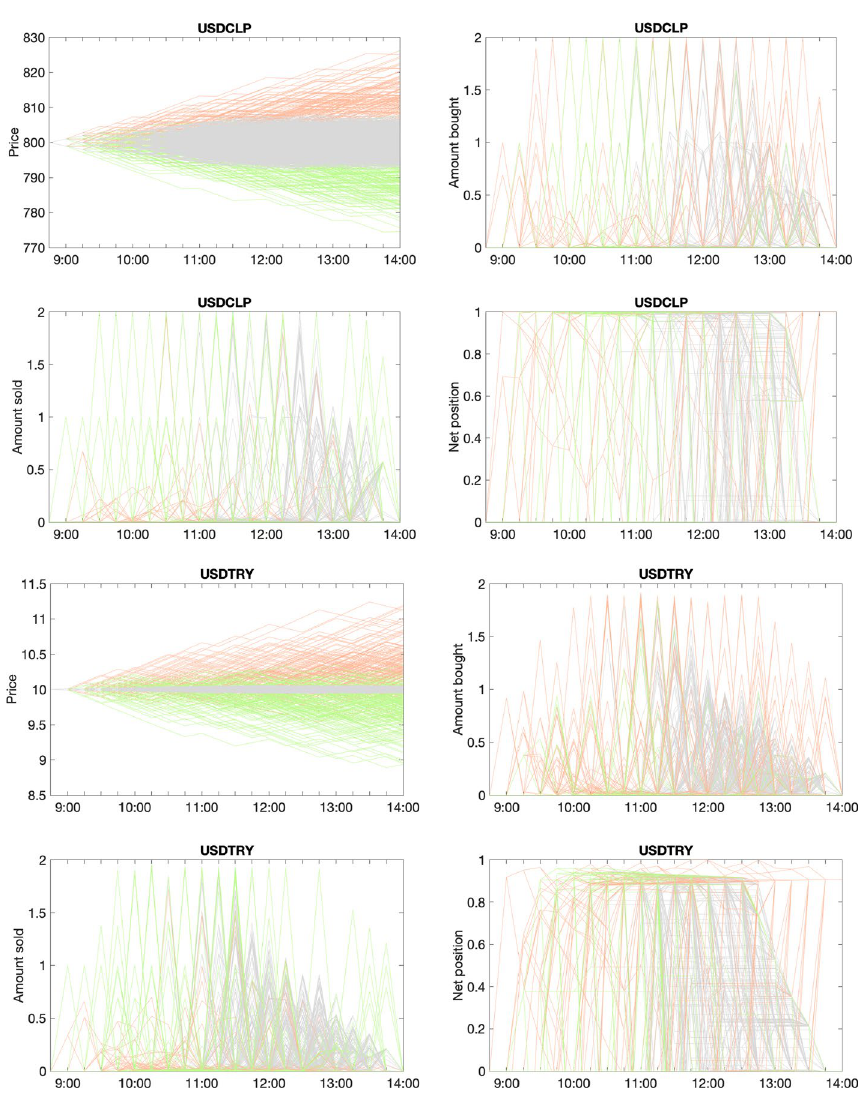
Fig. 10 Sample of the RN solution described in "Setting 2: Speculative trading" section. FX price follows the dynamics in (15). The figure shows the results from 4 exchanges: USDCLP, USDTRY, GBPUSD and USDJPY. Scenarios in grey follow the Vasicek model during the entire day. Scenarios in green and red have a shock during the day, which changes the dynamics to a GBM model with negative(green) or positive(red)